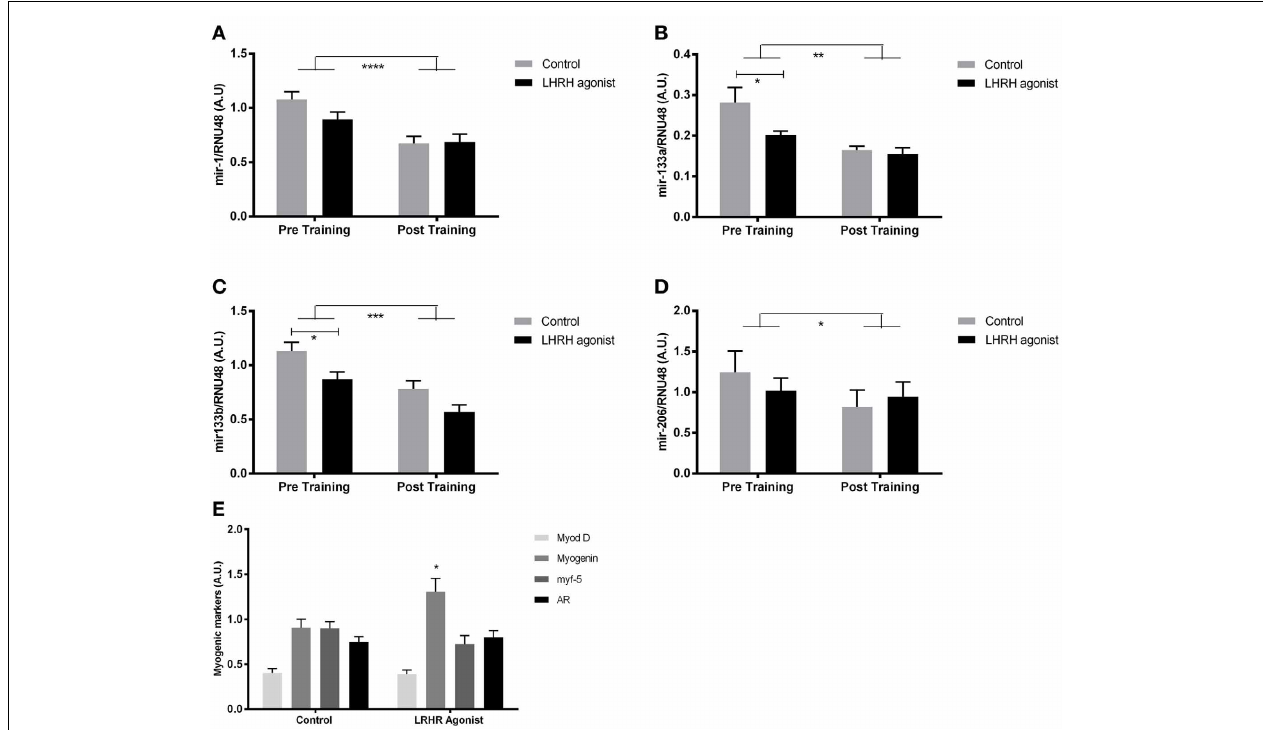
expression of mir-133a (B) ( ∗ P = 0 . 02) and mir-133b (C) ( ∗ P = 0 . 03), but not mir-1 (A) or miR-206 (D) in testosterone blocked patients at rest before training. The expression of myomiRs in testosterone blocked patients and healthy controls were identical after the training period. The expression of MYOG (E) ( ∗ P < 0 . 05) at rest was upregulated in testosterone-blocked participants. No regulation of MYOD, MYF-5, or AR was detected. Data are mean ±